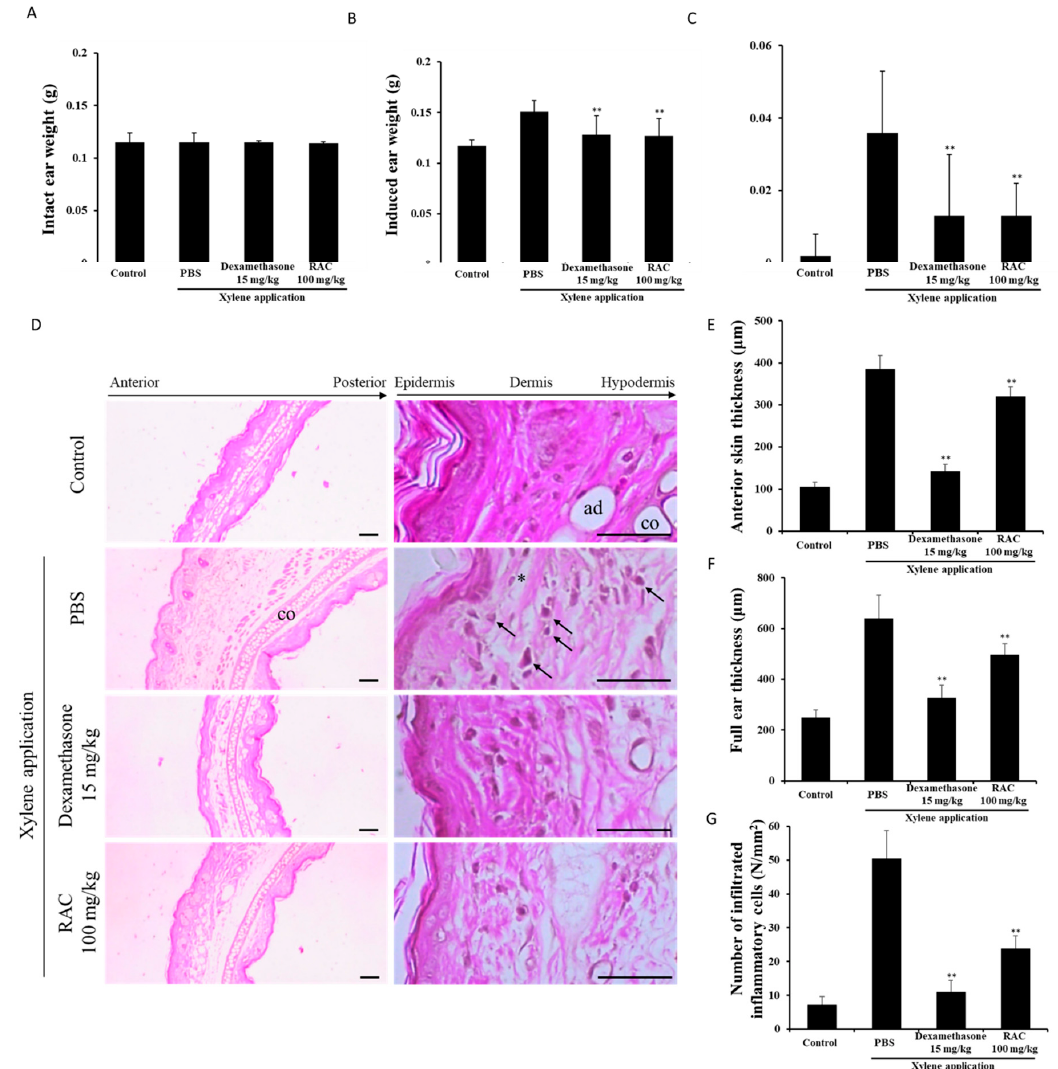
Figure 4. E ff ect of RAC on the xylene-induced mouse ear edema model. The mice were pretreated with PBS or dexamethasone (15 mg / kg) intraperitoneally or RAC (100 mg / kg) orally before xylene application on the anterior surface of the right ear for 2 h. ( A ) Intact ear weight, ( B ) induced ear weight and ( C ) differences in ear weight were measured. ( D – G ) For histological analysis, mouse ears were fixed and stained with H&E. ( D ) Representative H&E-stained mouse ear images of each group. Severe vasodilation (asterisks) and infiltration of inflammatory cells (arrows) were observed in the xylene only-treated group. ( E ) Anterior skin thickness, ( F ) full ear thickness and ( G ) the number of infiltrated inflammatory cells were measured. Values are presented as the mean ± SD of nine experimental individuals. * p < 0.05, ** p < 0.01 compared with the xylene-only-treated group. ad, adipocytes; co, chondrocytes. Scale bars represent 80 μ m.